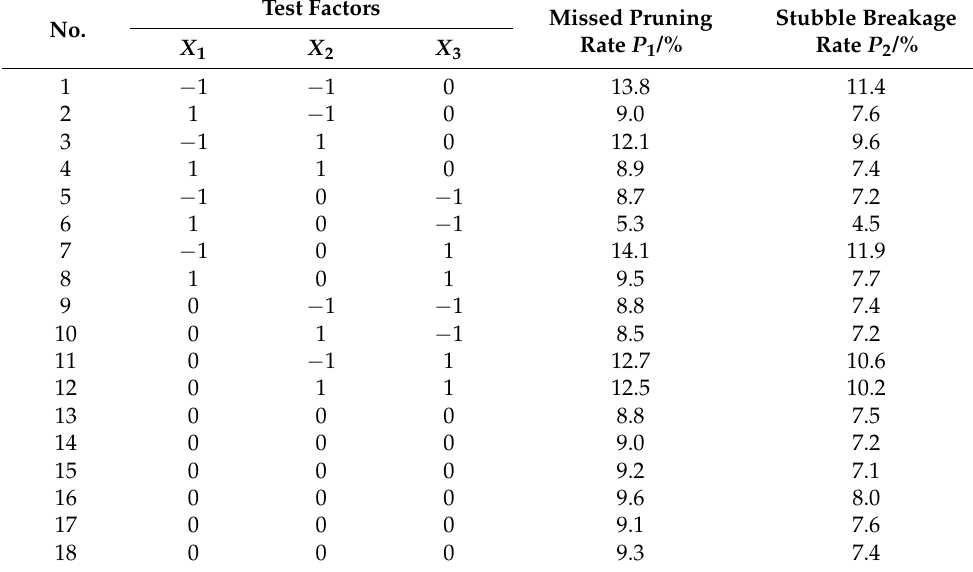
Table 4. Tests plan and